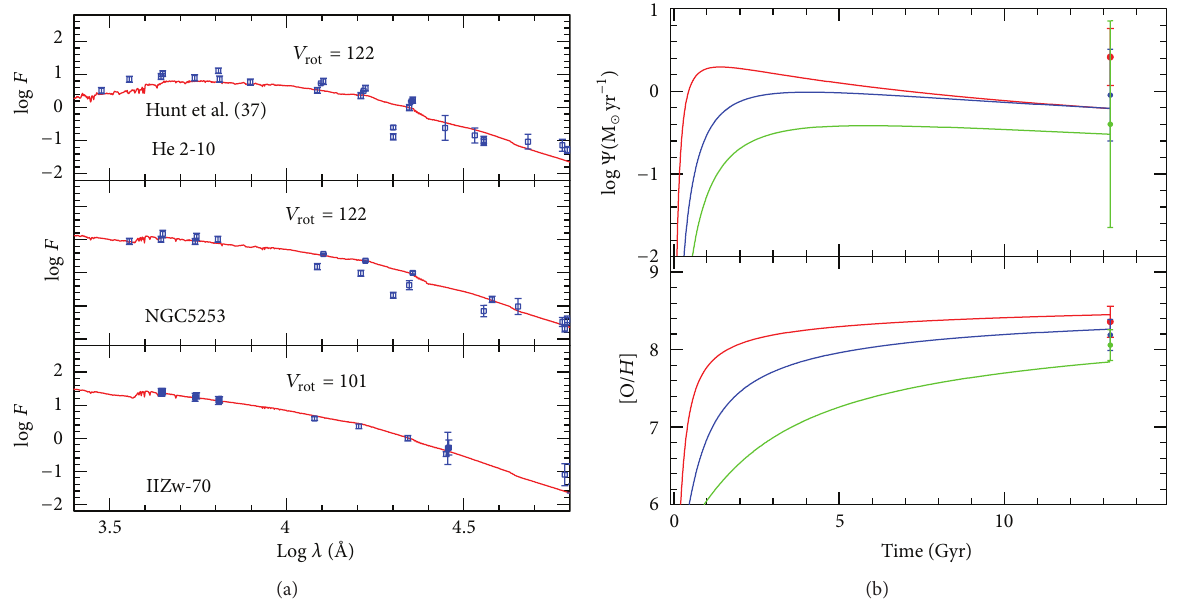
Figure 10: (a) The resulting spectral energy distributions—red solid lines—obtained to reproduce the observations from Hunt et al. [123]— blue open squares—for three BCD galaxies. (b) The star formation history and age-metallicity relation with which we obtain the SEDs which best fit observed